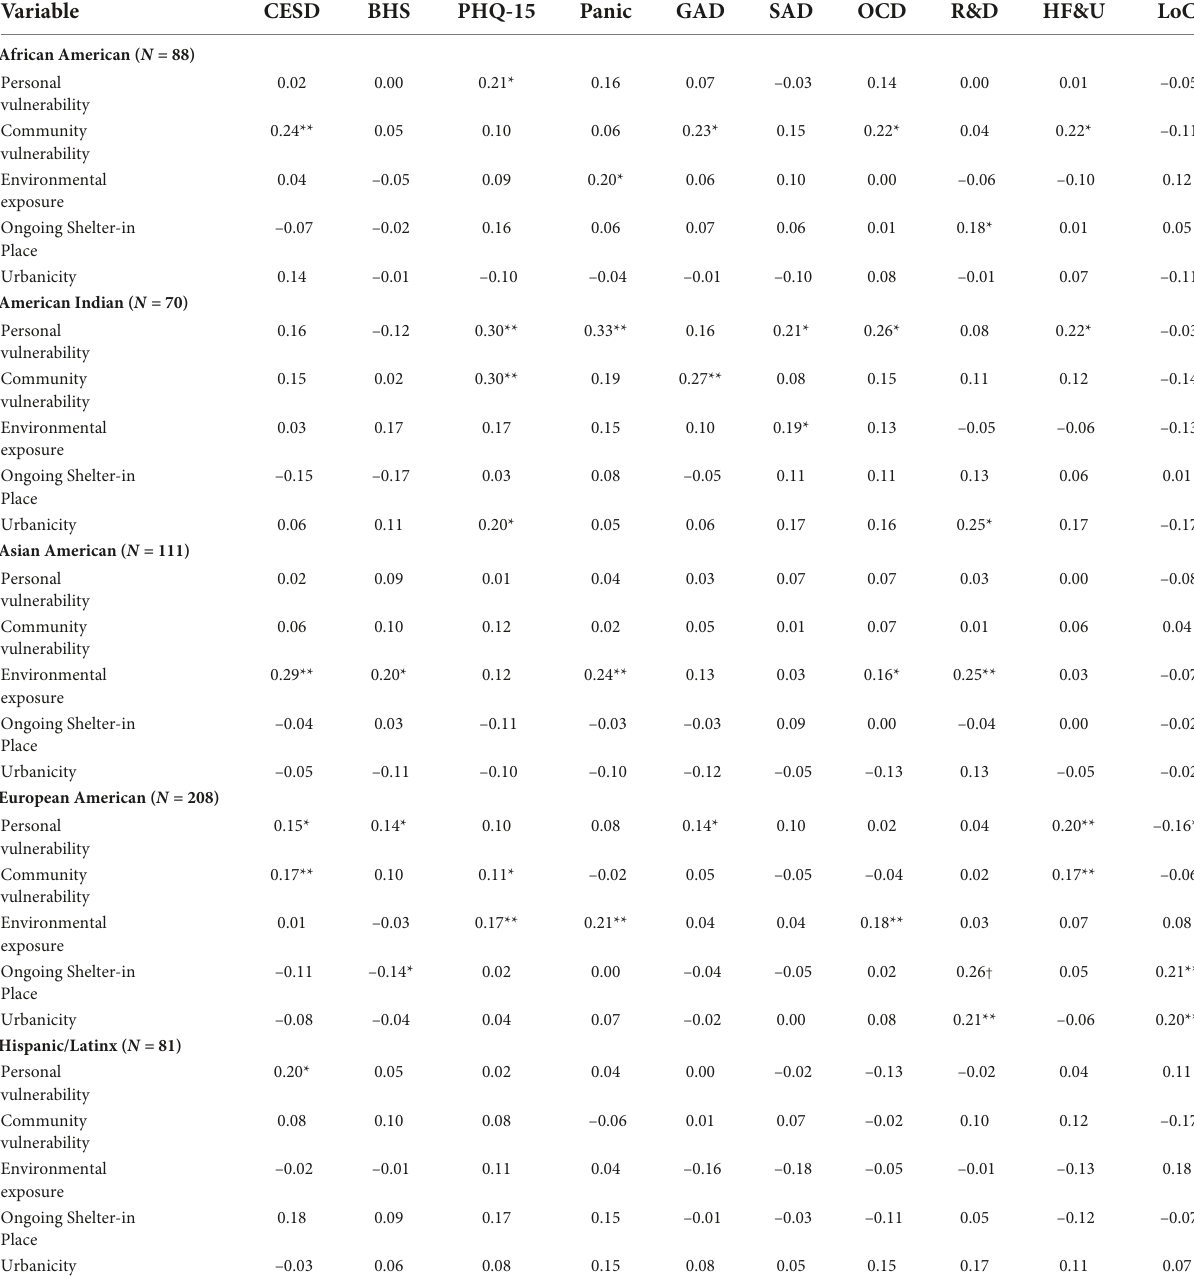
TABLE 4 Interitem correlations of mental health outcomes and risk by ethnicity group, controlling for age. Variable CESD BHS PHQ-15 Panic GAD SAD